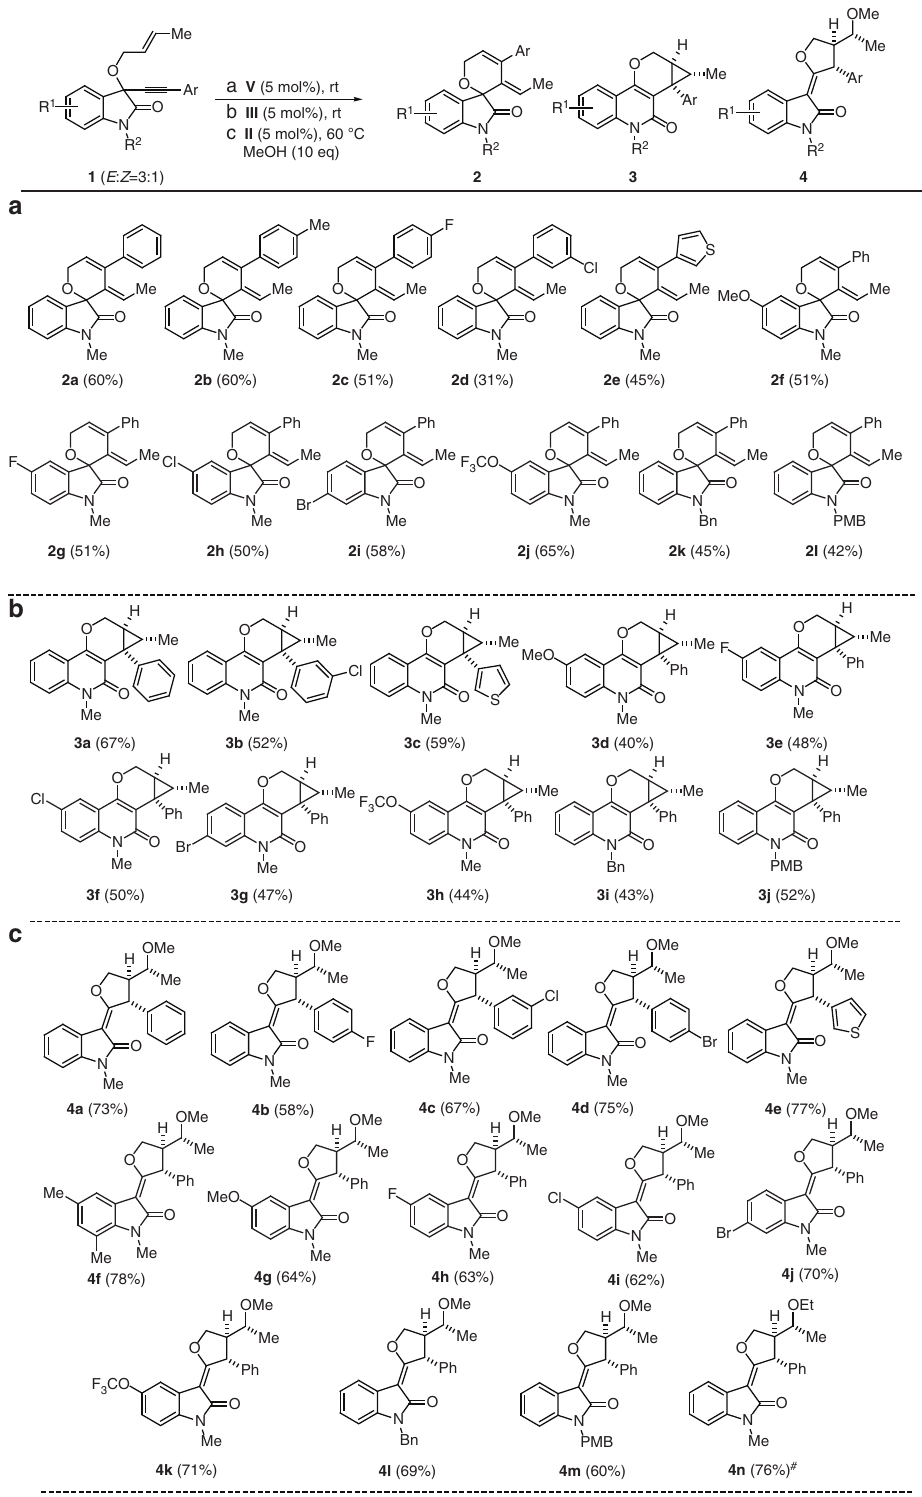
Figure 2 | A collection of diverse small molecules obtained via LDS appraoch. ( a ) Synthesis of spirooxindoles 2 : 1,6-enynes 1 (0.1M), V (0.5mol%), DCM and 0 (cid:2) C to rt, overnight. ( b ) Synthesis of quinolones 3 : 1,6-enynes 1 (0.1M), III (0.5 mol%) and DCM, 0 (cid:2) C to rt, overnight. ( c ) Synthesis of df -oxindoles 4 : 1,6-enynes 1 (0.1M), MeOH (10 eq), II (0.5 mol%), DCE and rt to 60 (cid:2) C, overnight. Bn, benzyl; DCE, dichloroethane; eq, equivalent; LDS, ligand-directed divergent synthesis; PMB, p -phenoxy benzyl; rt, room temperature.